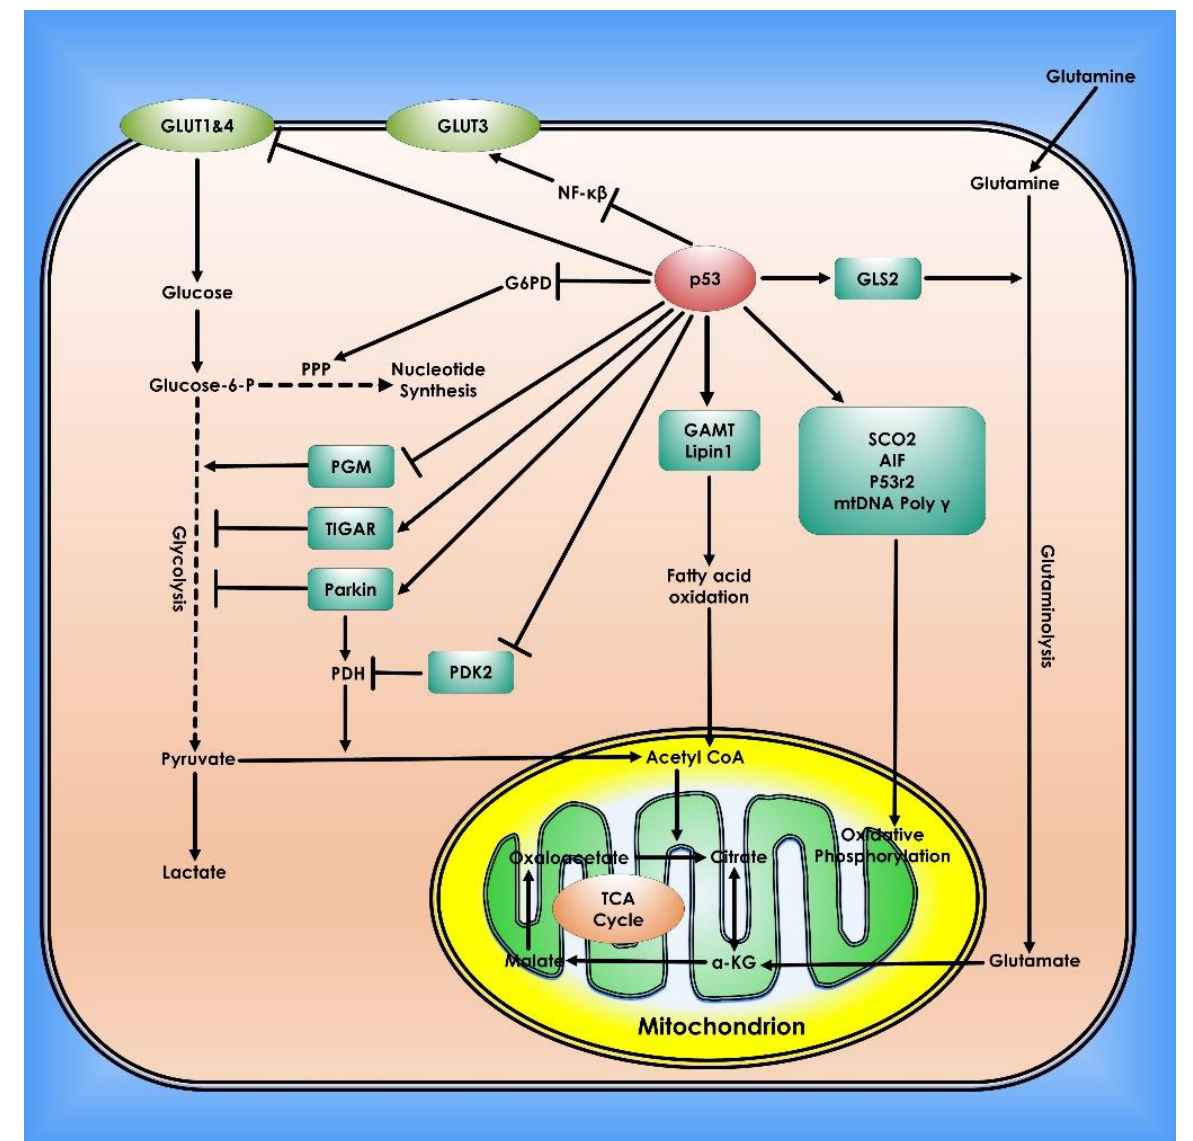
Figure 4. Role of p53 in Cancer Metabolism. In cells, p53 controls mitochondrial oxidative phospho- rylation, glycolysis, glutaminolysis, and fatty acid oxidation. To preserve mitochondrial integrity